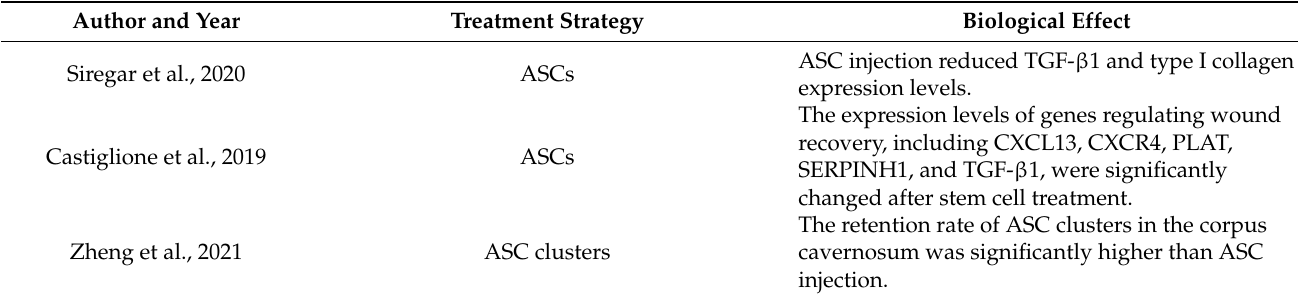
Table 4. Overview of ASC-based therapy for erectile